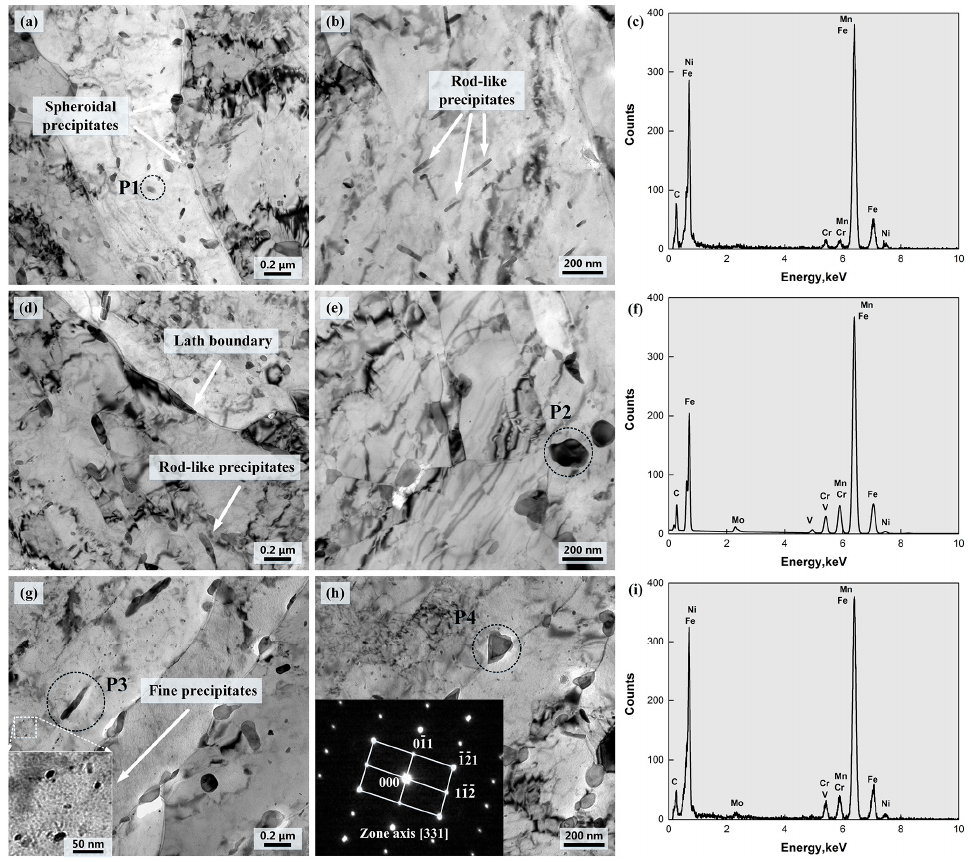
Figure 5. TEM morphology of the experimental steel. ( a , b ) sub-surface, ( d , e ) t /4, ( g , h ) t /2, ( c , f , i ) represent the EDS images of P1, P2, and P3, respectively.